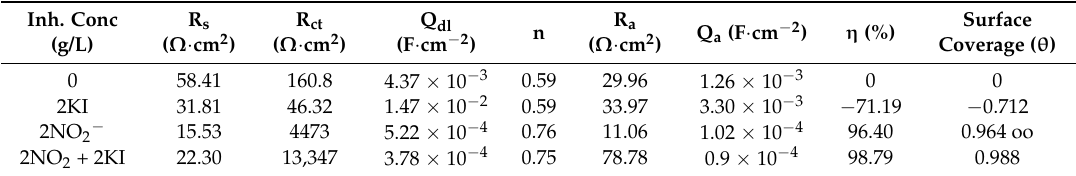
Table 3. Impedance parameters for mild steel in bicarbonate/chloride solution in the absence and presence of KI at 2000 rpm at room temperature.